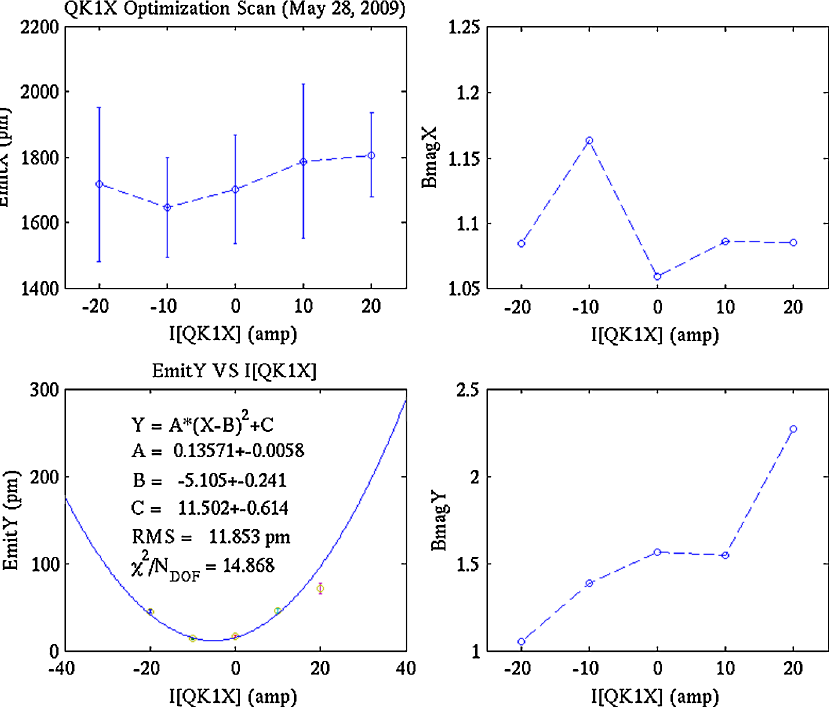
FIG. 6. (Color) Emittances and betatron mismatch factors (Bmag X, Y) measured in the ATF2 extraction line in May 2009 during coupling minimization with one of the skew correction quadrupoles. The Bmag X, Y factors quantify the distortions of the beam ellipses in both transverse planes with respect to those of the ideal matched betatron phase space, following the definition in [43]. In the vertical dimension, BmagY exceeds unity indicating apparent